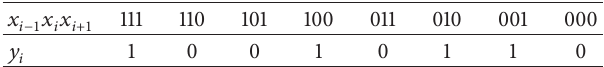
Table 3: Updating of the state of any entity 𝑖 corresponding to the elementary CA rule number